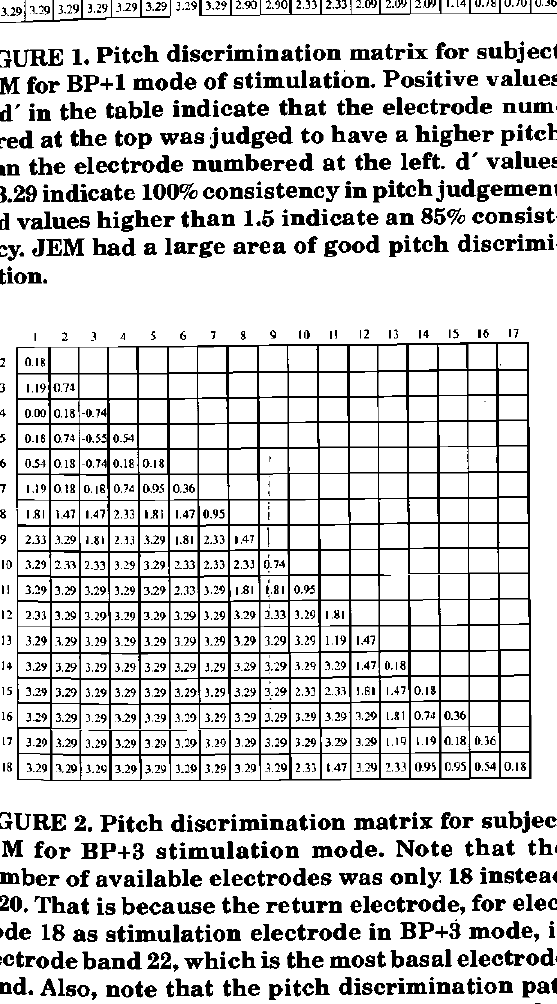
FIGURE 4. Pitch discrimination matrix for subject EWB. This subject exhibited poor pitch discrimina- tion throughout the electrode array, although he did a little bit better toward the apical